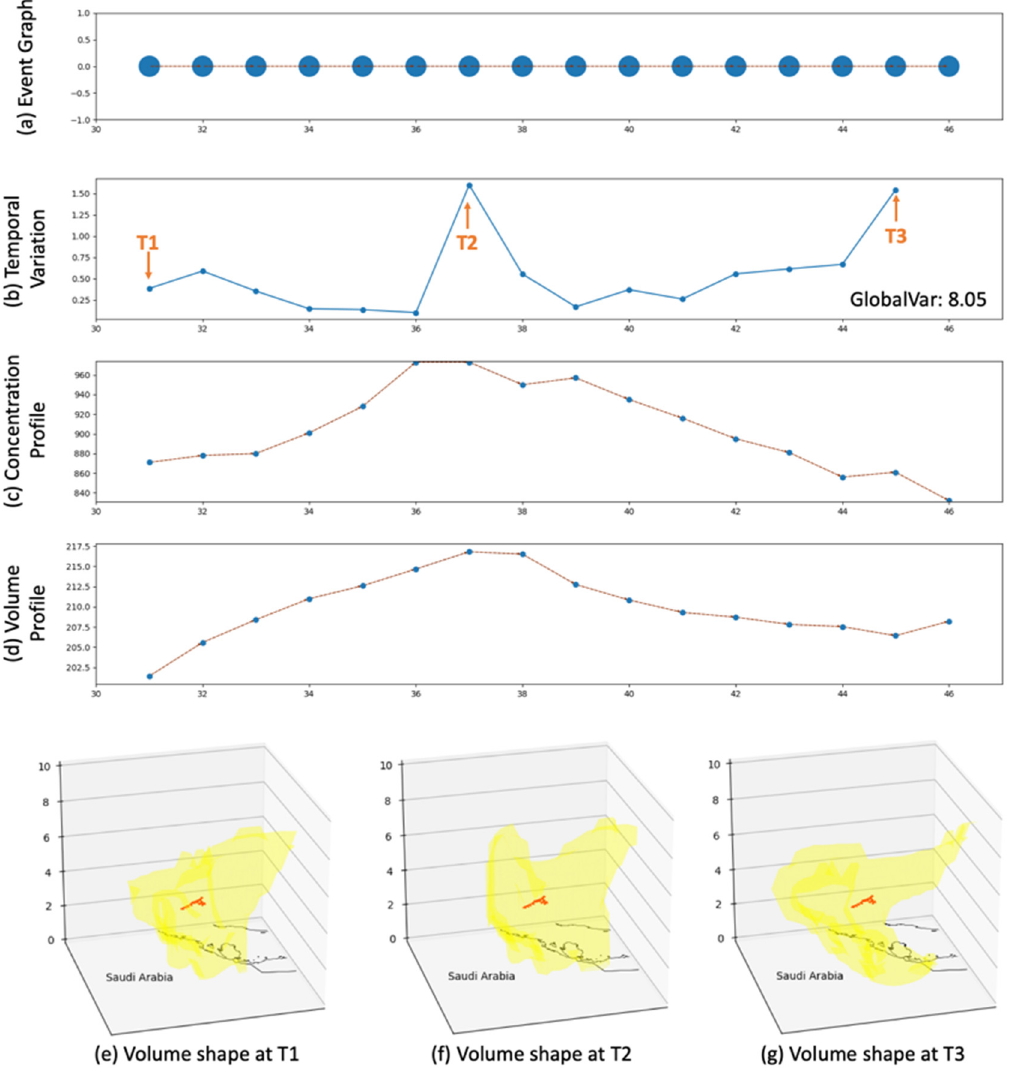
Figure 8. Event graph for the Southern Arabian Peninsula dust event in late July 2014. In Figure a, c, and d, each arrow is color-coded by the weight of the edge.